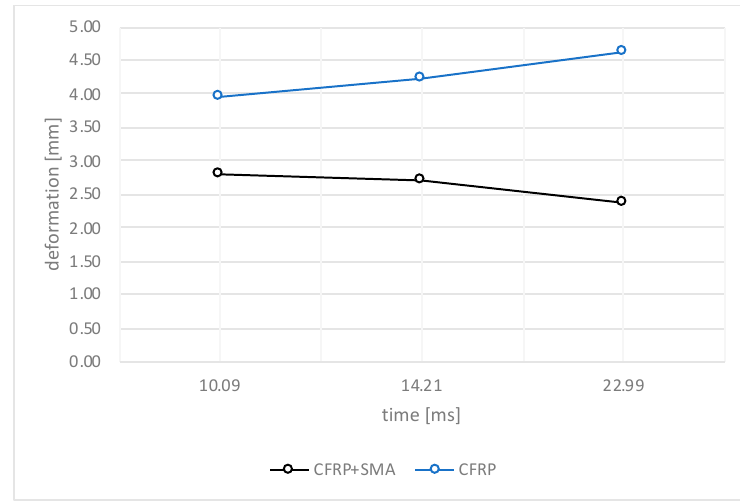
Figure 4. Deformation of the impacted samples.